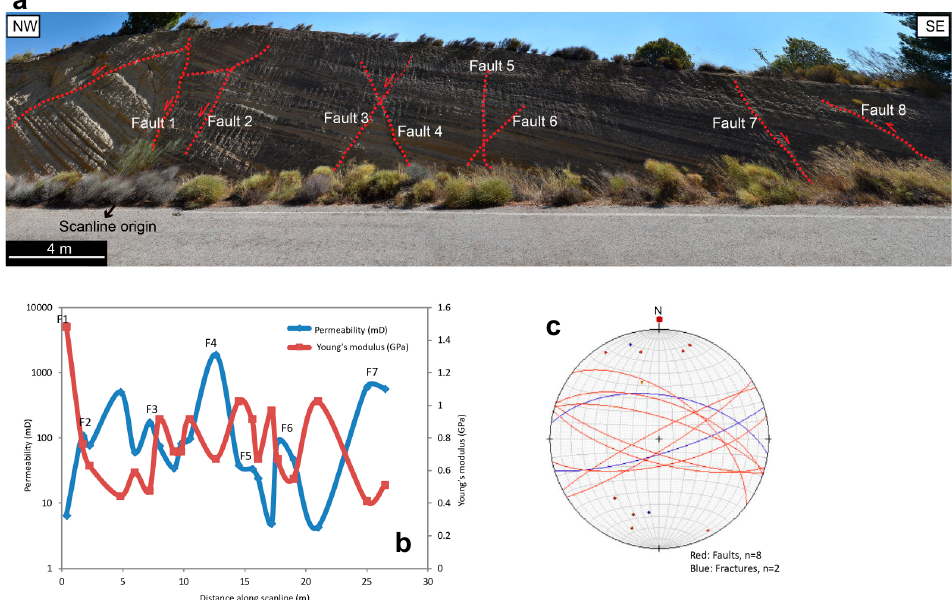
Figure 16. ( a ) Section in the Tablate B locality in the southeastern edge of the Granada Basin. Several small normal faults located in the damage zone of a segment to the south of the Padul Fault have been measured along the scanline. ( b ) Permeability and Young’s modulus measurements along the scanline. ( c ) Stereoplot showing the orientation of faults and fractures. Table 7. XRD analysis of the samples from Tablate B locality in the southeastern edge of the Granada Basin. The distance corresponds to the distance from fault, which is also plotted on the x-axes of the plots in Figure 14.